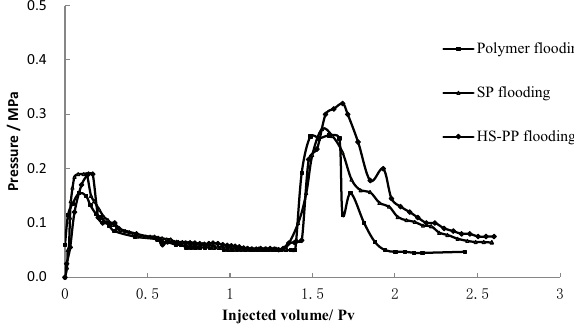
Fig. 2 Pressure change in displacement experiment in model